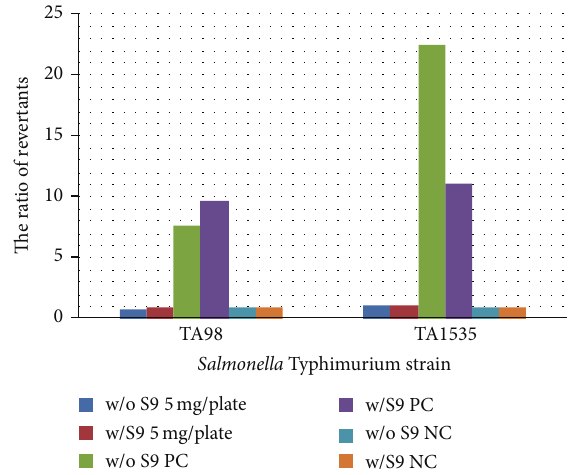
Figure 1: The influence of a probiotic-combination mix or promutagen on Salmonella Typhimurium. The reactions were separated with or without the addition of S9. Promutagens were added as a positive control group (with S9 addition, BP for TA98 and 2-AA for TA1535; without S9 addition, NQNO for TA98 and SA for TA1535). Sterile water was added as a negative control (NC). The ratio was defined as revertants in the reagent group: revertants in the NC